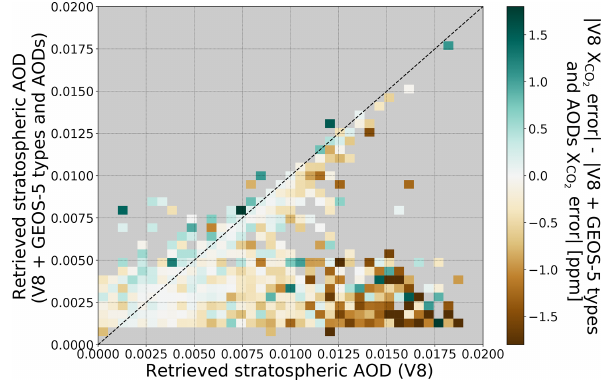
Figure 12. Retrieved stratospheric AOD from V8 versus retrieved Figure 13. Retrieved AOD from V8 versus retrieved AOD from V8 stratospheric AOD from V8 + GEOS-5 types and AODs with low with low uncertainty for northern Africa and central Asia. Color uncertainty for the Southern Ocean. Color represents the change in represents the change in the absolute value of the X CO error between the two retrieval types, the absolute value of the X CO tween the two retrieval types, for which green demonstrates an im- 2 for which green demonstrates an improvement over V8 and brown provement over V8 and brown represents a represents a worsening.